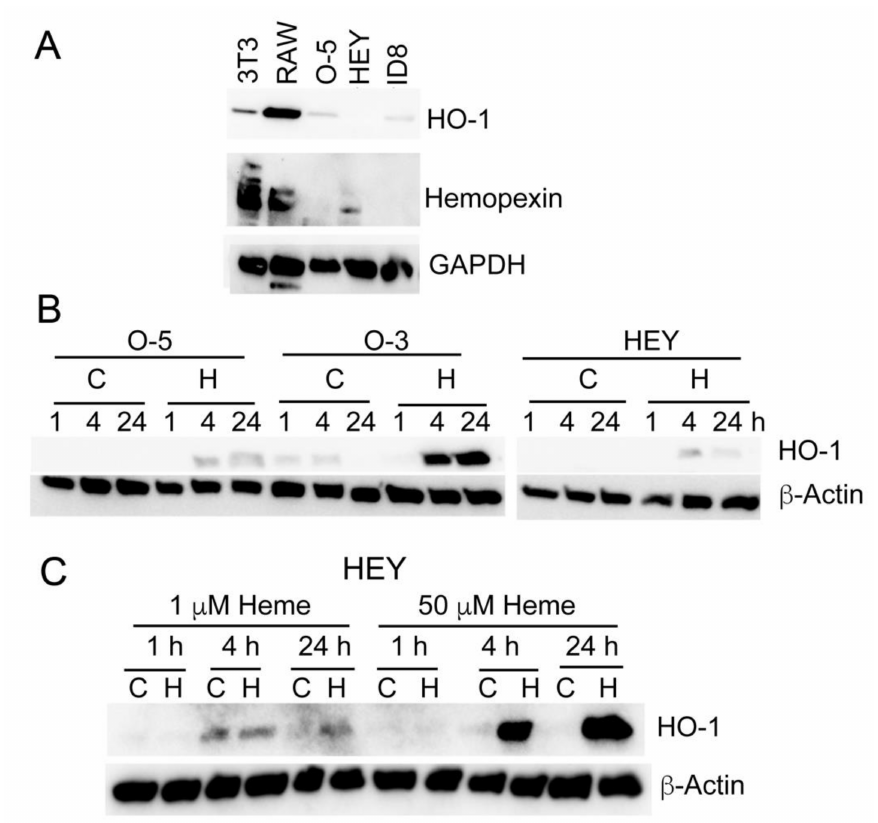
Figure 5. Heme induces HO-1, Hx and DNA damage in ovarian cell lines. ( A ) Immunoblot analysis with antibody against HO-1 and Hx in NIH3T3 fibroblasts, RAW macrophage cell line and ovarian cell lines. ( B) HO-1 and HO-2 were determined by immunoblotting lysates of HEY and OVAR-5 (OV-5), OVAR-3 (O-3) ovarian cancer cells treated with heme (H, 50 µ M) or control ( C ) for 1–24h. Treatment of HEY cells with heme at 1 and 50 µ M. Immunoblot analysis of HO-1 levels is shown at 1, 4, and 24 h. Please see the whole western blots in File